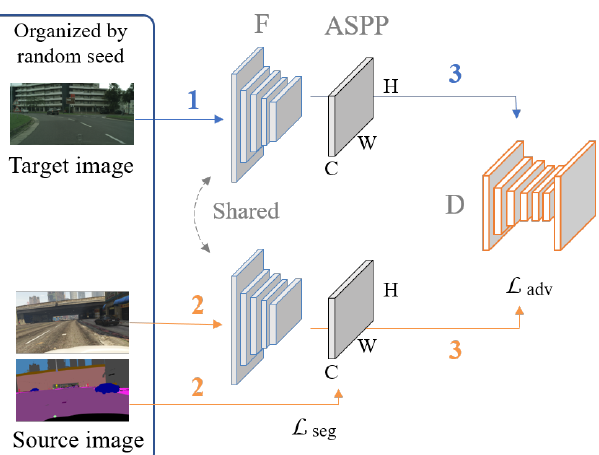
Figure 3. Vanilla DASS training flow based on adversarial training. Step 1, 2, and 3 in the figure are explained in detail in Section